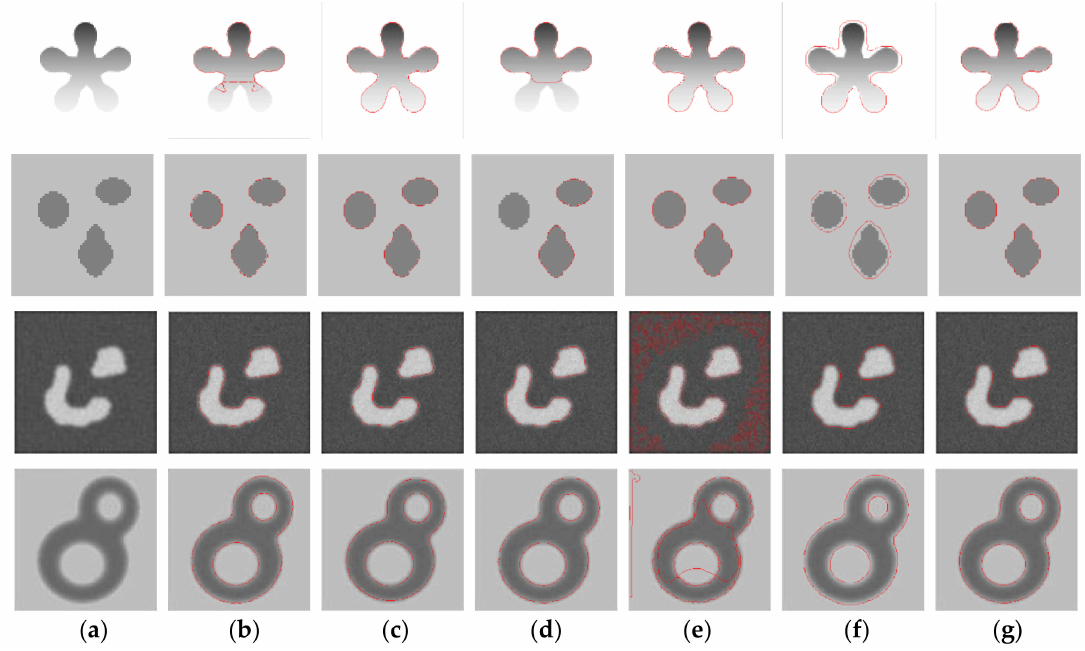
Figure 2. The segmentation results of images with intensity inhomogeneity for the six models. ( a ) Original image, ( b ) C–V model, ( c ) LBF model, ( d ) SBGFRLS model, ( e ) LIF model, ( f ) LSACM model, and ( g ) SPFLIF-IS